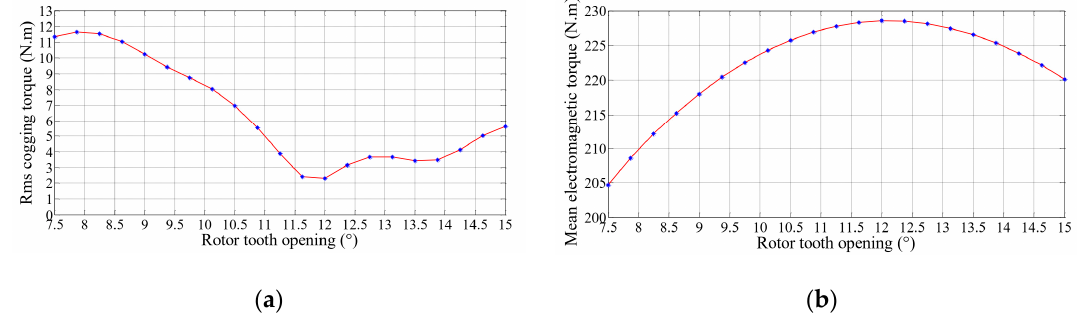
Figure 8. ( a ) Variation of the cogging torque in function of rotor tooth width; ( b ) variation of mean electromagnetic torque in function of rotor tooth opening.